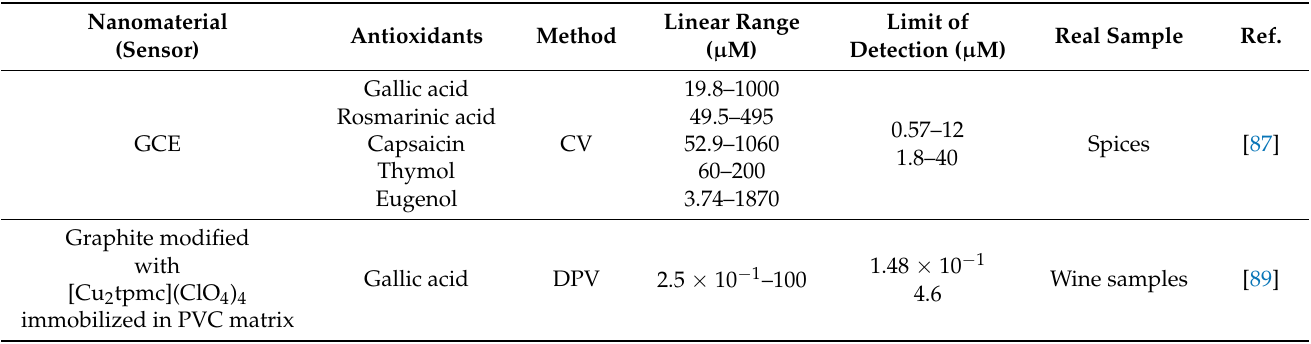
Table 1. Several examples of electrochemical assays based on sensors for the determination of antioxidants in food